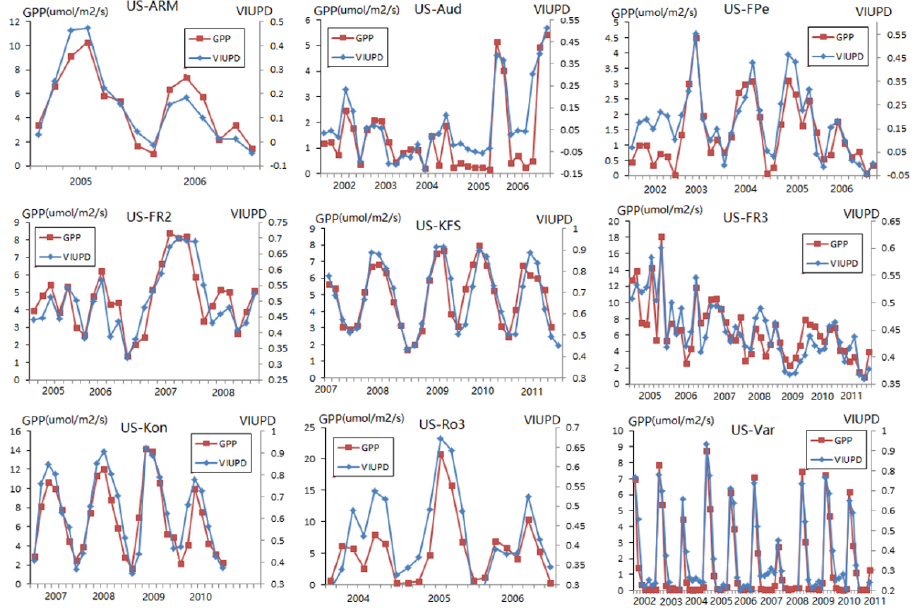
Figure 10. Seasonal patterns of VIUPD and GPP. Subfigures show the seasonal patterns of VIUPD and GPP in the flux tower sites of US-ARM, US-Aud, US-FPe, US-FR2, US-KFS, US-FR3, US-Kon, US-R03 and US-Var. The red points stand for the GPP and the blue points stand for the VIUPD.